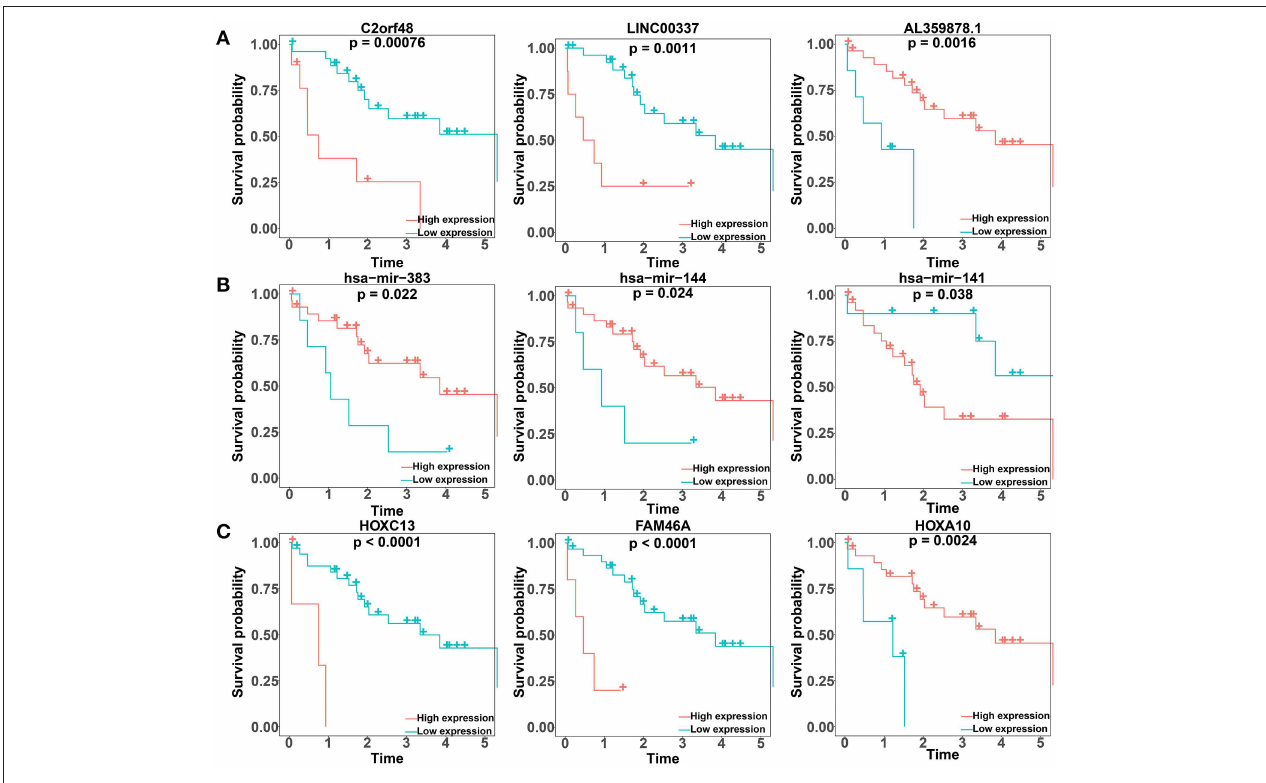
FIGURE 4 | Kaplan–Meier survival curves for the top three lncRNAs, miRNAs, and mRNAs related to overall survival based on their optimal cutoffs in cholangiocarcinoma. The horizontal axis represents the overall survival time in years; the vertical axis represents the survival probability.